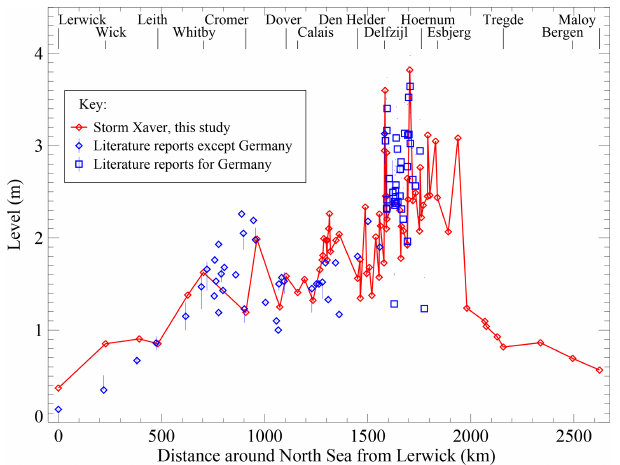
Figure 5. Skew surge during Storm Xaver on 5–6 December 2013. The values are calculated from tide gauge records and arranged by counter-clockwise distance around the North Sea starting from Ler- wick. Literature reports are included for